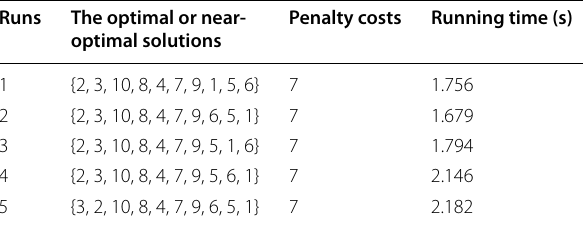
Table 4 Obtained optimal or near-optimal solutions for case study 1 Runs The optimal or near‑ optimal